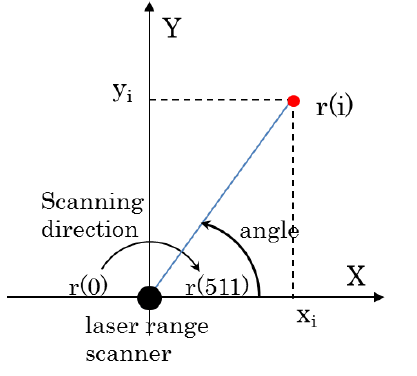
Fig. 6. Coordinate Transformation of ange Data